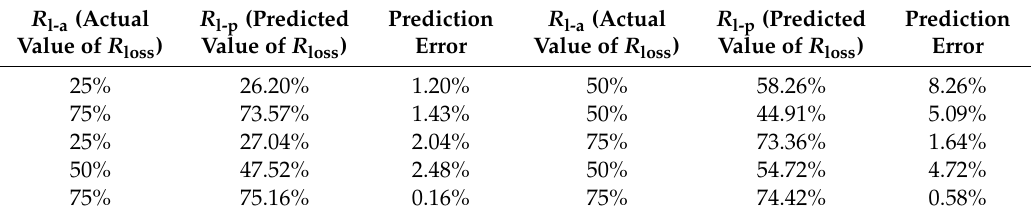
Table 9. Comparison of monitored and actual values.